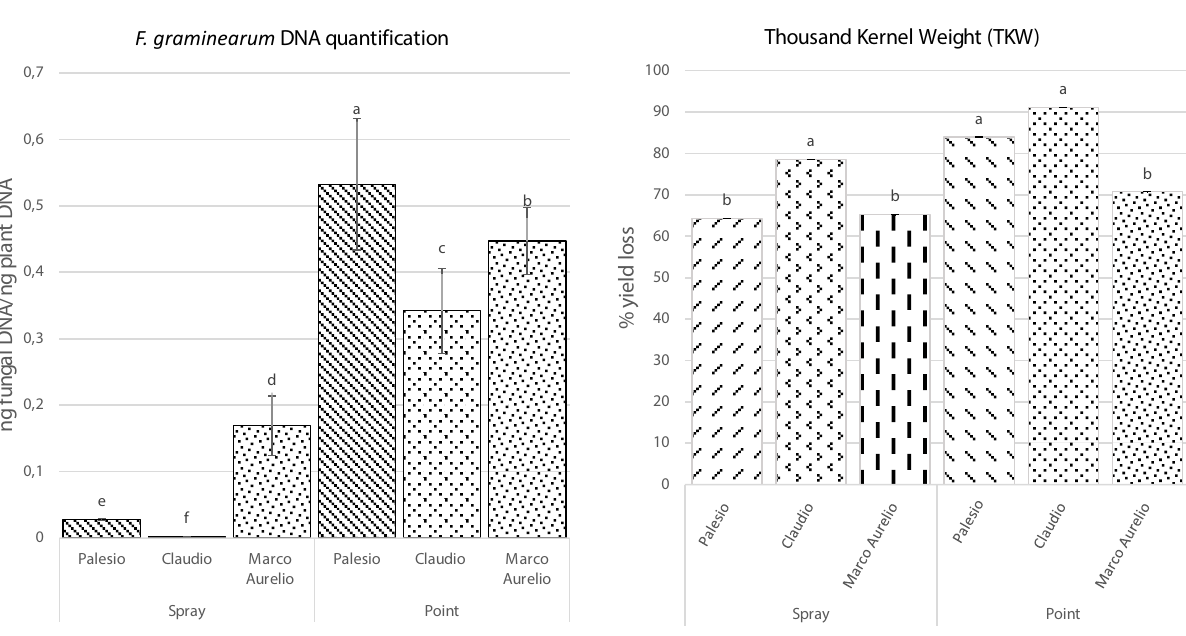
Figure 4. Yield losses (%) based on TKWs for inoculated and con- trol plants after spray or point inoculations with F. graminearum at 2,500 conidia per spike. Data represent averages and standard errors for three independent replicates performed with at least 20 plants for each genotype × inoculation combination. Statistical analyses were performed according to two way analysis of variance (ANOVA) with Tukey test at 0.95 confidence level ( P <